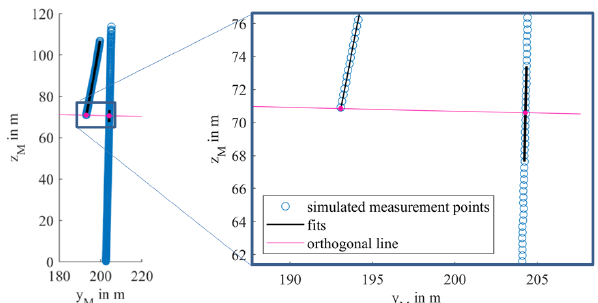
Figure 7. Standard deviation of the fourth-degree polynomial fit along the z M axis for the (a) lower blade and (b) upper blade through 263 simulated rotor blade scans repeated 10000 times. Figure 8. Simulated measuring points on the blade and tower for one scan with noise added to the blade and tower points (blue cir- cles) for the case γ = 0 ◦ with fits through simulated points in black. The orthogonal distance with the tower and blade is shown in pink.